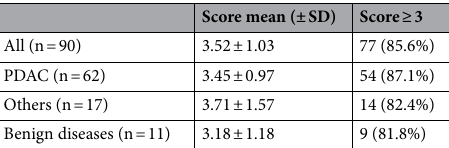
Table 5. Tissue amount assessed using scoring system for PDAC, others, and benign diseases.